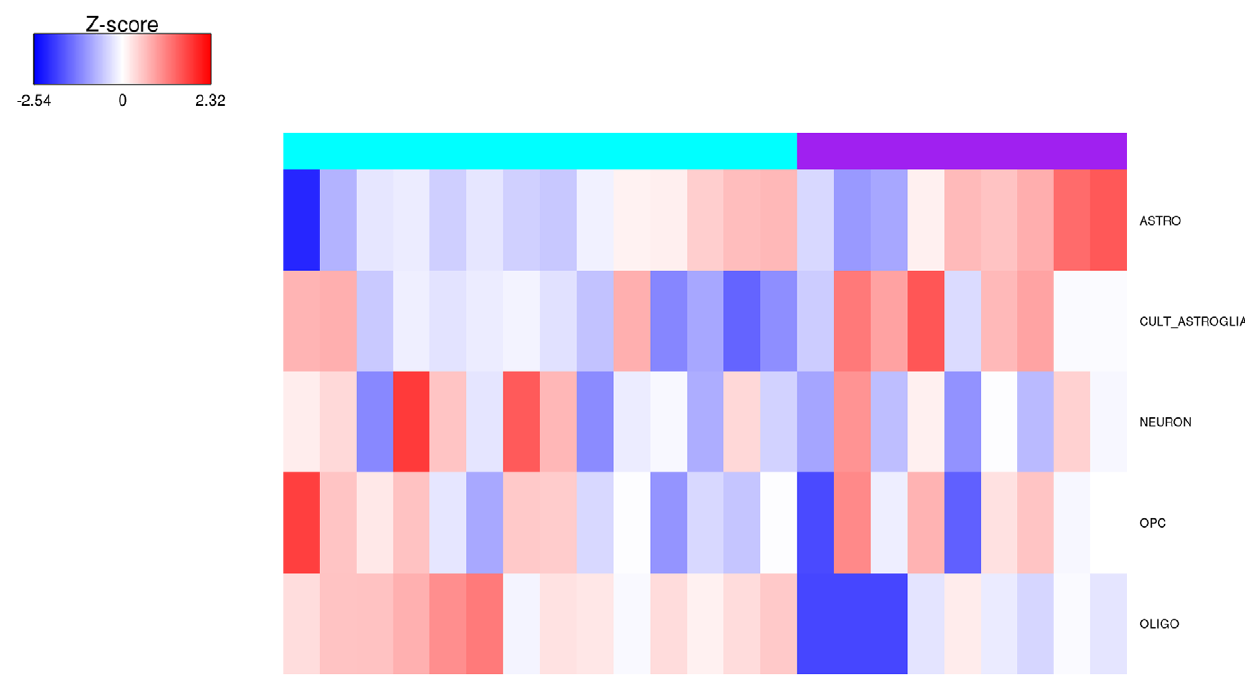
Figure 6. Comparison of gene expression signature of the two DIPG groups with specific neural lineages. A GSEA analysis was processed using the gene list previously described by Lei et al [32] and derived from the gene sets specifically enriched in astrocytes, oligodendrocytes, neurons, oligodendrocytes progenitors cells and cultured astroglial cells. Heatmap of the enrichment scores of each DIPG sample is represented with a red to blue color scale shows the range from the highest to lowest enrichment score.